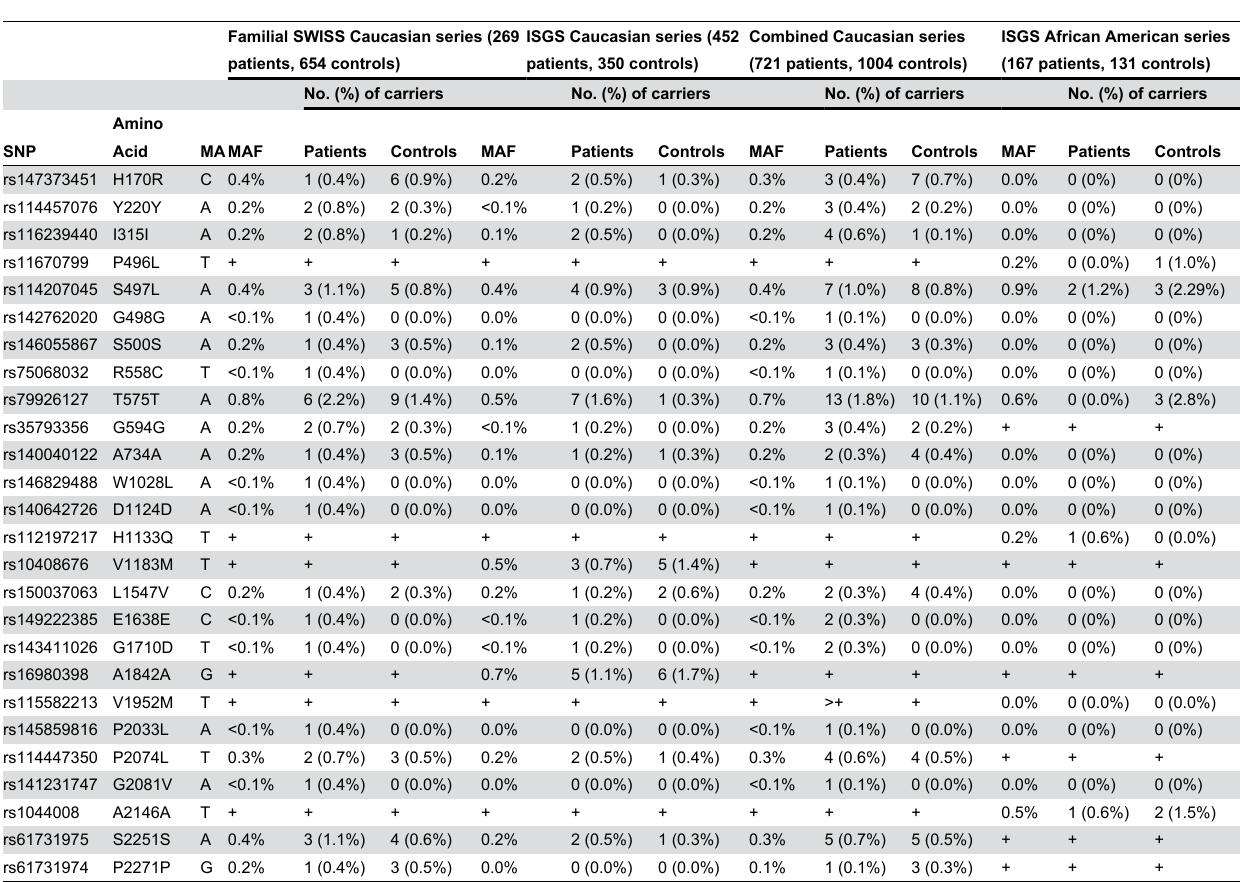
Table 3. Summary of variants with a minor allele frequency of less than